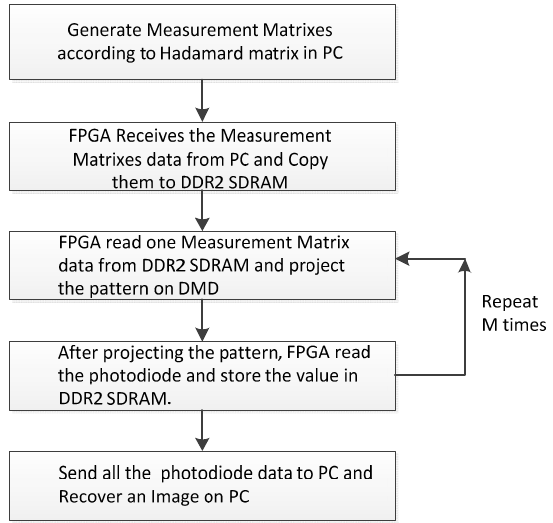
Figure 4. The workflow of single-pixel camera.